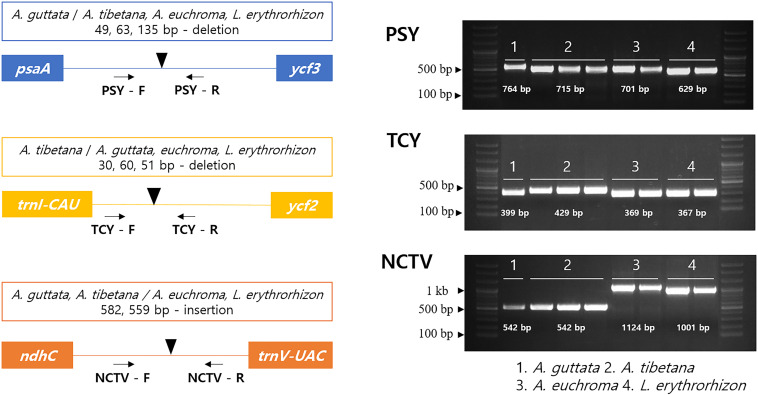
Schematic representation of indel markers for Arnebia and Lithospermum species. Primers for PSY (psaA- ycf3), TCY (trnI-CAU-ycf2), and NCTV (ndhC-trnV-UAC) were tested. Control samples were used in a marker test (Supplementary Table 4). 1: A. guttata; 2: A. tibetana; 3: A. euchroma; and 4: L. erythrorhizon.